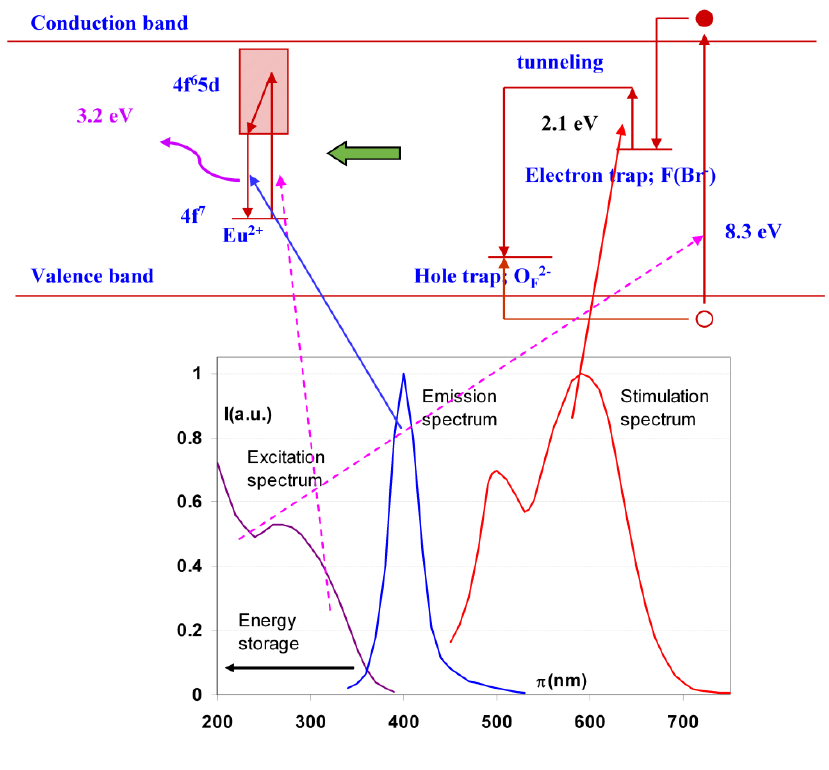
Figure 11. Energy diagram showing photo-stimulated luminescence in BaFBr:Eu 2+ and the relation with the stimulation, excitation and emission spectrum of the